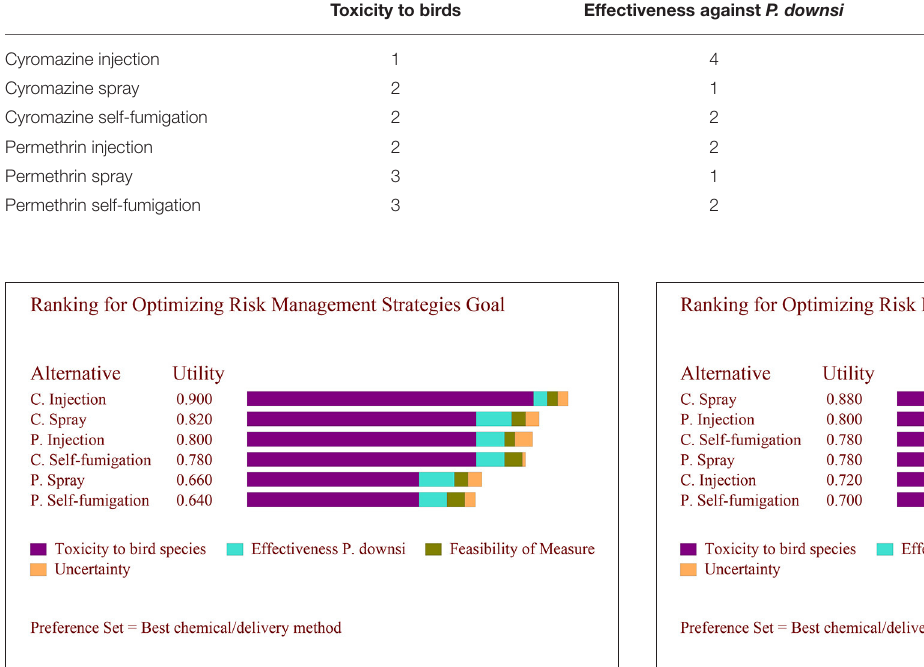
FIGURE 2 | Ranking of the six alternatives considering the weights from Scenario B.